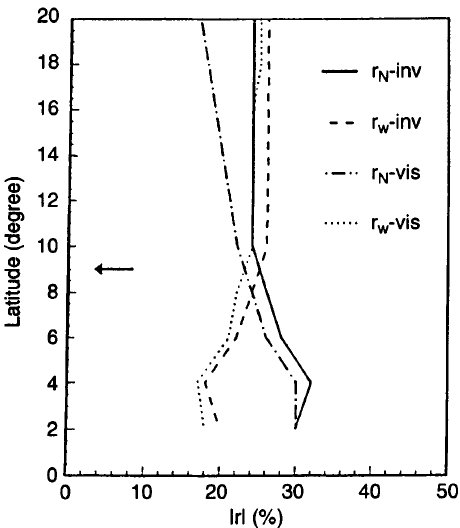
Fig. 6. Linear energy flux coe(cid:129)cient (in %) at di(cid:128)erent latitudes ( (cid:14) ). Solid and dashed lines : r N and r W , respectively, for the inviscid case. Center-dashed and dotted lines : r N and r W , respectively, for the dissipative experiment. C0. T (cid:136) 60